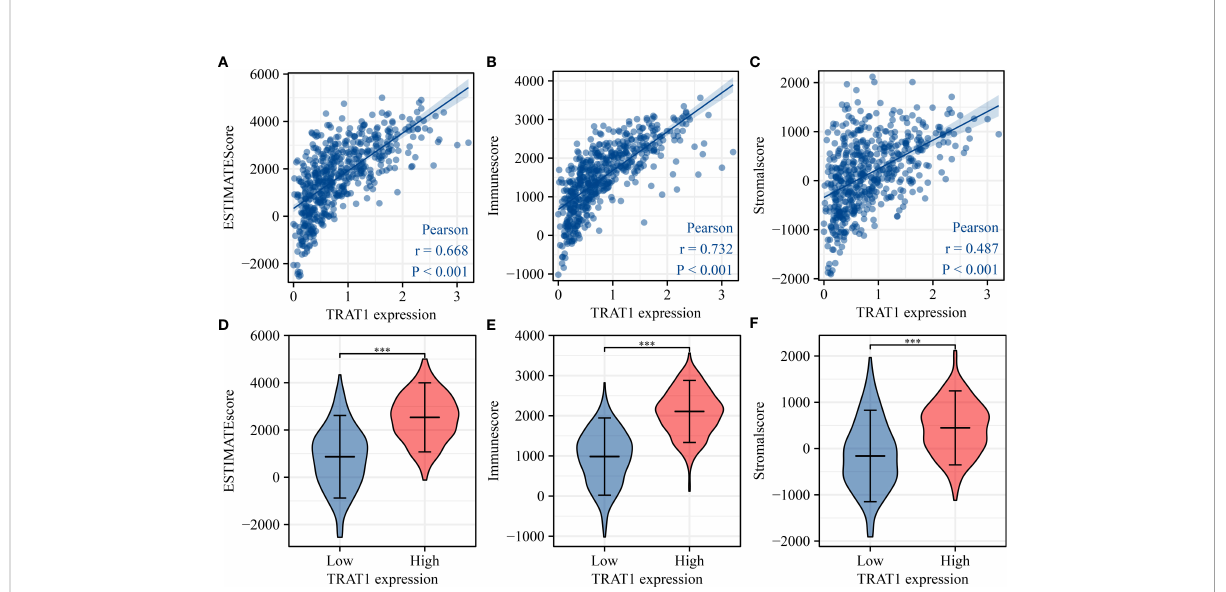
FIGURE 8 TRAT1 expression was signi fi cantly correlated with the levels of stromal, immune, and ESTIMATE scores in LAC tissues. (A) Stromal score; (B) Immune score; (C) ESTIMATE score; (D – F) The levels of stromal, immune, and ESTIMATE scores in high- and low-TRAT1 expression groups. LAC, lung adenocarcinoma.